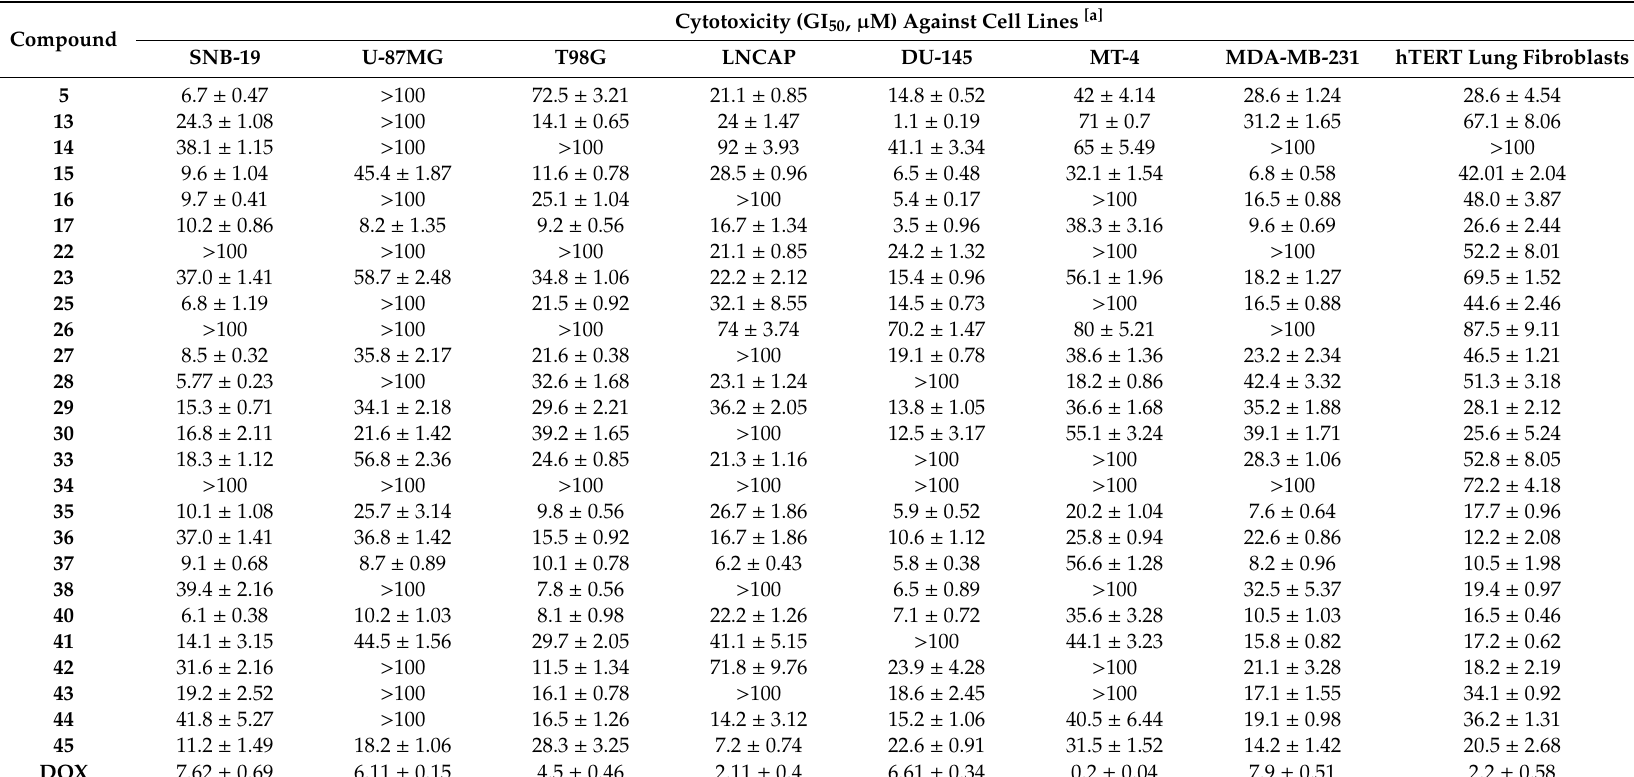
Table 1. Cytotoxicity of aryl substituted 1-hydroxy-9,10-anthraquinones 5 , 13–17 , 22 , 23 , 25–30 , 33-38,